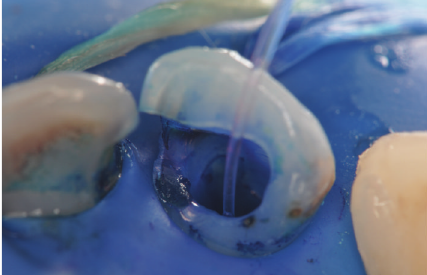
Figure 8: Optical fiber positioned and irradiation of red laser (40 J/cm 2 ).